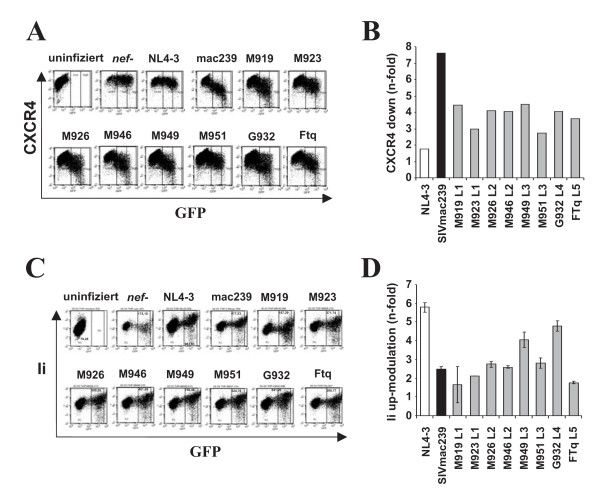
Modulation of CXCR4 and the MHC-II associated invariant chain. (A) Jurkat T cells were transduced with HIV-1 NL4-3 Nef/eGFP constructs and assayed for surface expression of CXCR4. The range of eGFP expression used to calculate CXCR4 modulation is indicated. (B) Quantitative assessment of down-modulation of CXCR4 by the indicated Nef proteins. (C) THP-1 cells were transduced with HIV-1 NL4-3 constructs coexpressing the indicated nef alleles and GFP and assayed for surface expression of Ii. The ranges of eGFP expression used to calculate receptor modulation are indicated. (D) Quantitative assessment of SIVsmm Nef-mediated down-modulation of Ii. Values give averages ± SD derived from five independent experiments. The asterisks denote a statistical significance (P < 0.05) between HIV-1 and SIV Nef activity.